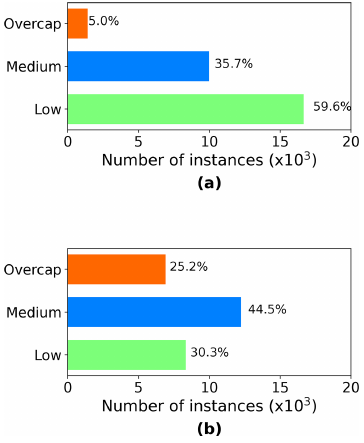
Figure 9. Number of instances in BuildingPaid categorical in the filtered data set: (a) 4 September 2010 and (b) 22 February